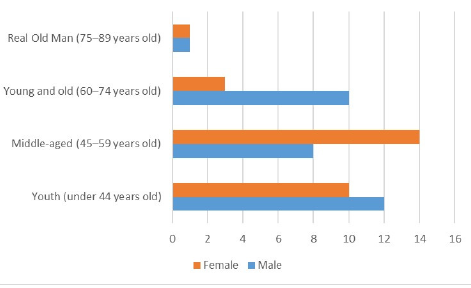
Figure 2. Age distribution of men and women. Table 1. Statistical table of basic information of the respondents. Table 2. Relevant survey results of